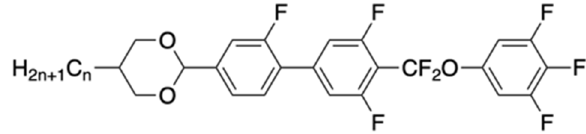
Figure 1. The conventional liquid-crystal compound.